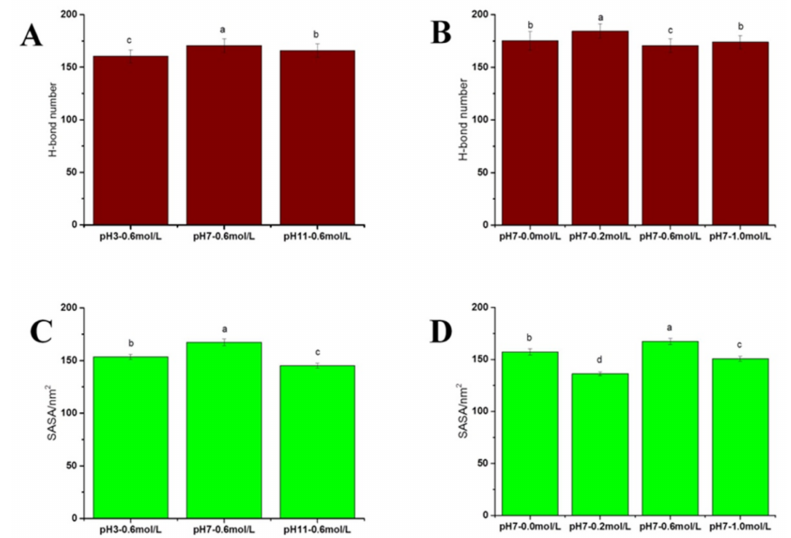
Figure 5. Changes in the H-bond number and SASA index at simulation time 80 ns–100 ns: ( A ) H- bond number under pH treatments; ( B ) H-bond number under NaCl treatments; ( C ) SASA index under pH treatments; and ( D ) SASA index under NaCl